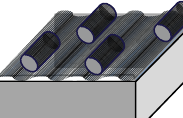
Figure 10. Schematic of the pre-alignment layer (blue), which anchors the LC molecules in the direction of the grooves being rubbed into the polyimide film with a velvet